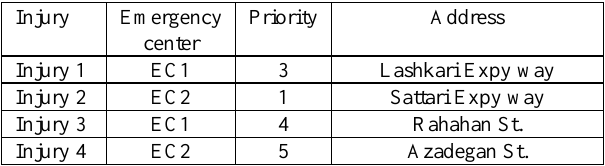
Table 1. Details of the injuries in the study area